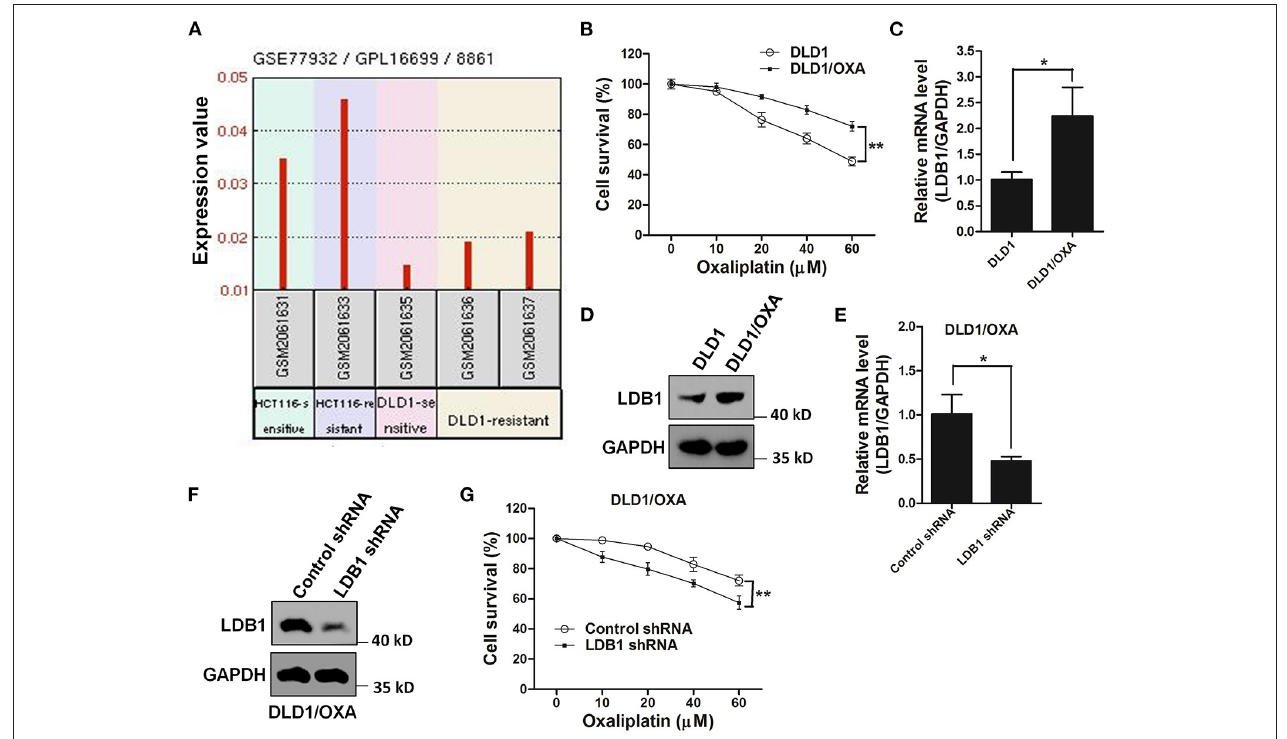
FIGURE 6 | LDB1 is involved in the drug resistance of oxaliplatin in colorectal cancer cells. (A) The gene expression levels of LDB1 in oxaliplatin-sensitive HCT116, oxaliplatin-resistant HCT116 (HCT116/OXA), oxaliplatin-sensitive DLD1 and oxaliplatin-resistant DLD1 (DLD1/OXA) were obtained from GEO database (GEO accession: GSE77932). (B) DLD1 and DLD1/OXA cells were incubated with indicated concentrations of oxaliplatin for 48h, followed by CCK-8 assay. (C,D) The expression levels of LDB1 in DLD1 and DLD1/OXA cells were analyzed by qRT-PCR (C) and western blot (D) . (E,F) The silencing effects of LDB1 shRNA in DLD1/OXA cells were analyzed by qRT-PCR (E) and western blot (F) . (G) DLD1/OXA cells infected with control or LDB1 shRNA-derived lentivirus were incubated with indicated concentrations of oxaliplatin for 48h, followed by CCK-8 assay. * p < 0.05, ** p <